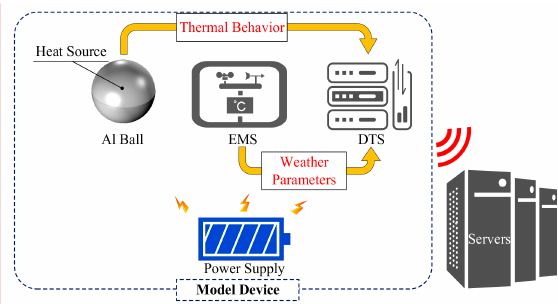
Figure 5. Frame diagram of EHT